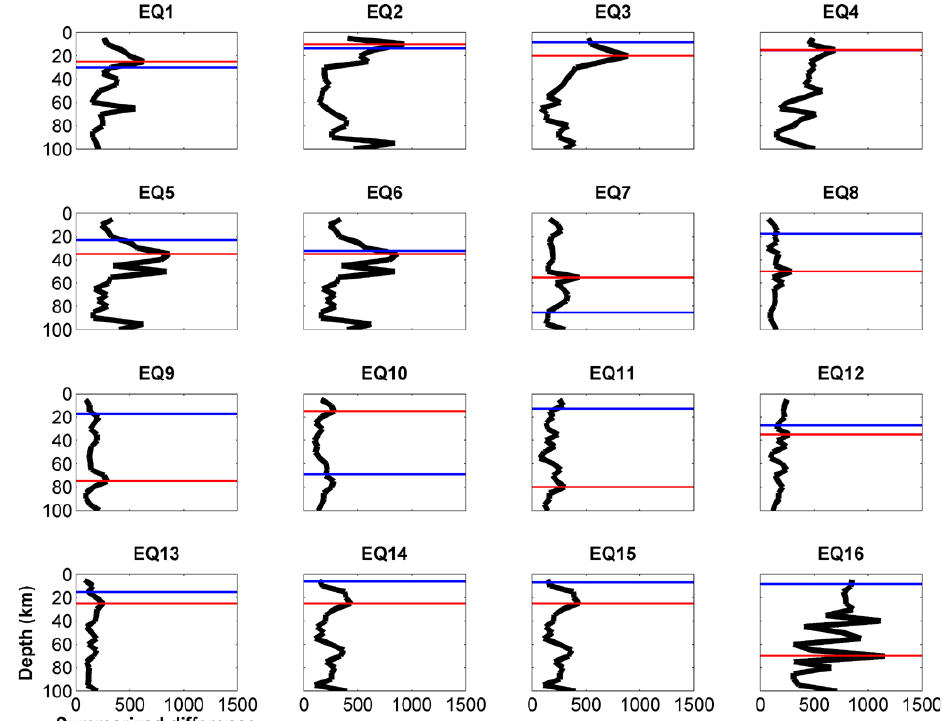
Fig. 5. The computed and reported hypocentre depths of 16earthquakes. The blue lines denote reported hypocentre depths. The black lines show summarised differences on the depth profile. The red lines are the computed depths determined by the largest summarised differences.